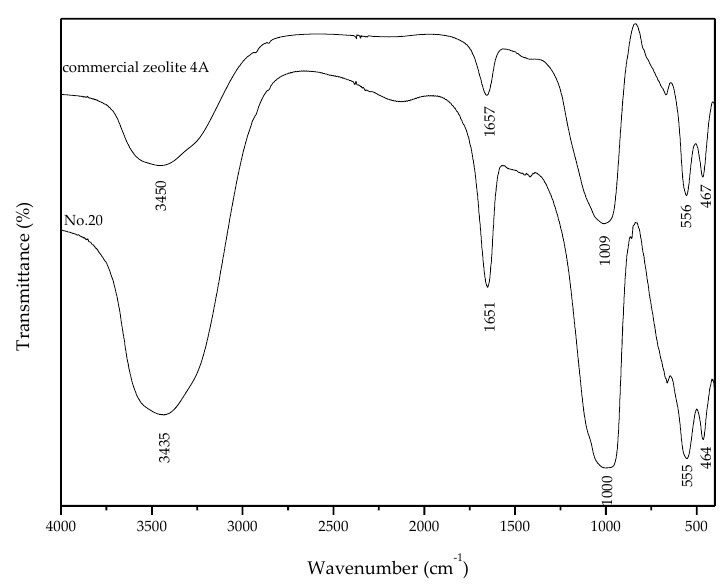
Figure 6. Fourier transform infrared (FTIR) spectrum of No. 20 and commercial 4A zeolite.